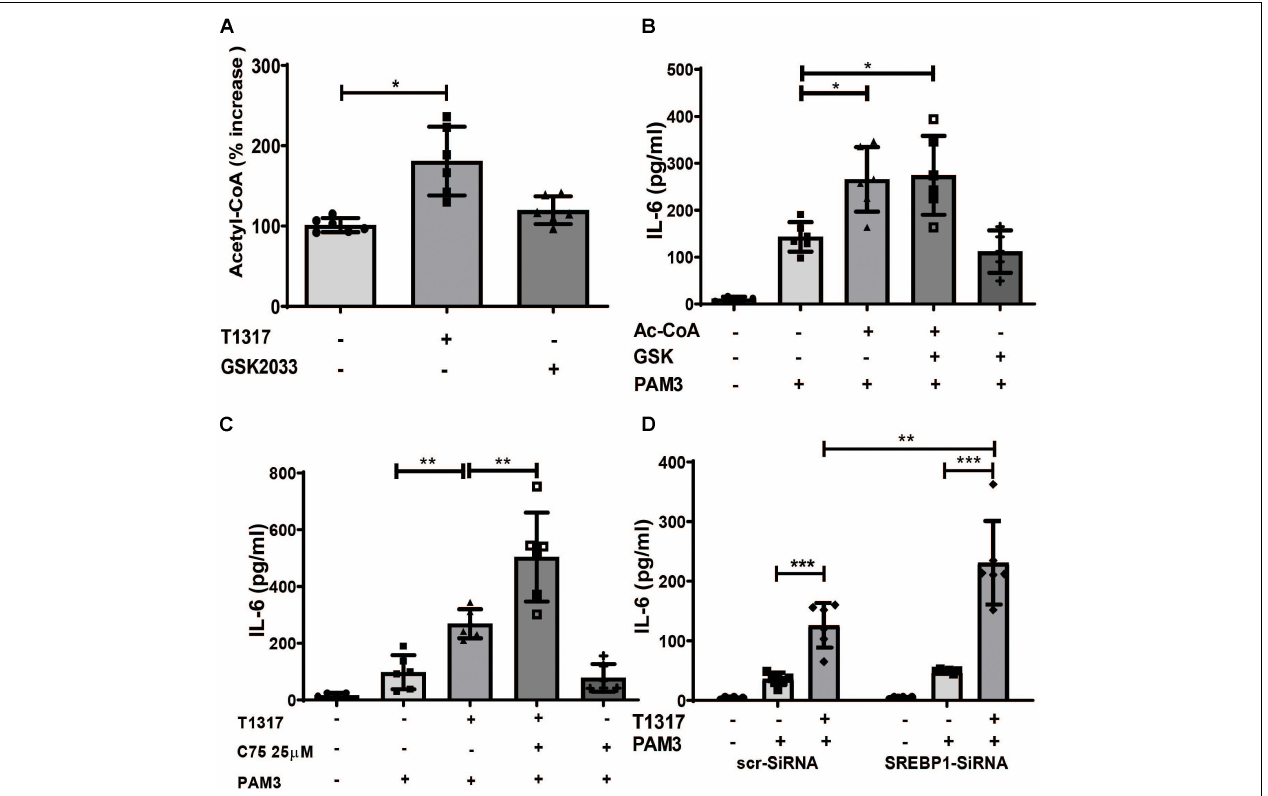
FIGURE 5 | LXR priming increases Acetyl-CoA levels, a novel mediator of inflammatory priming. (A–C) Monocytes were treated as indicated with 2 µ M T1317 (LXR agonist), 5 µ M GSK2033 (LXR antagonist), 500 µ M Acetyl-CoA, 25 µ M C75 (FASN-inhibitor) or vehicle for 24 h. (A) cells were lysed and acetyl-CoA concentration measured on day 3. (B,C) cells were kept for 5 days in complete medium and restimulated with 5 µ g/ml Pam3cys for 24 h. IL-6 was measured in the supernatant. (D) monocytes were transfected with siRNA against SREBP1 or scrambled siRNA, treated with 2 µ M T1317 or vehicle for 24 h and kept for 5 days in complete medium. Then cells were restimulated with 5 µ g/ml Pam3cys for 24 h and IL-6 was measured in the supernatant. Graphs represent mean values ± SD of six individuals in three different experiments. * P < 0.05, ** P < 0.01, and *** P <